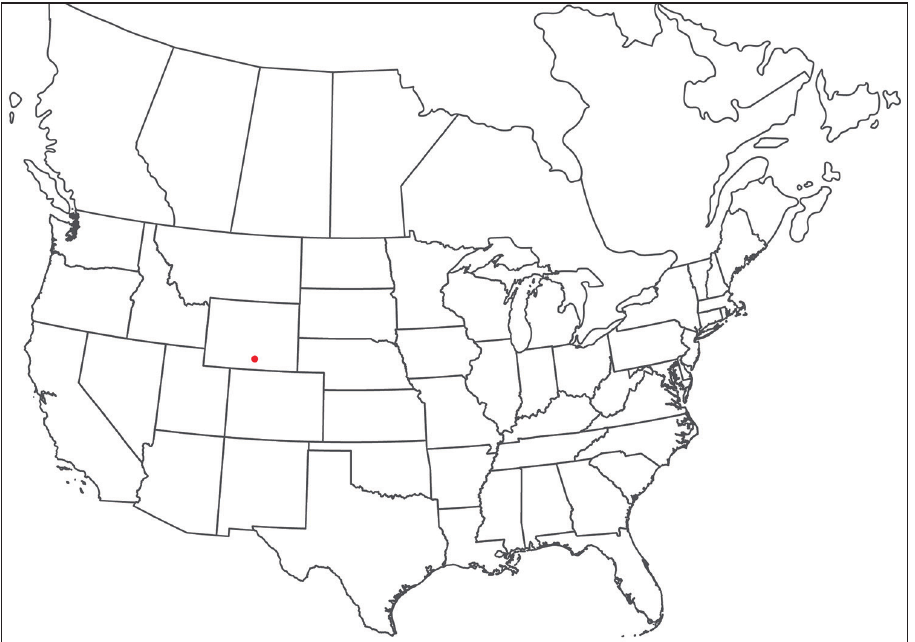
Figure 170. Torrenticola occidentalis